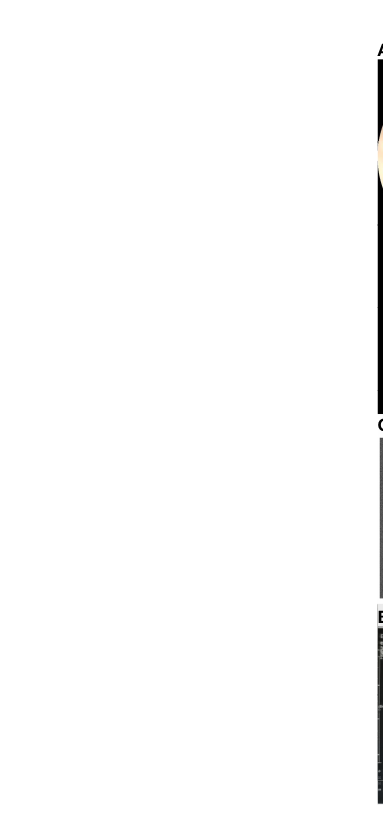
FIGURE 2 | (A) Fundus examination of patient 2 revealed a circumscribed, nodular, white lesion of the retina located in the peripheral quadrant, which was associated with tortious feeding vessels and subretinal yellow-white deposits. (B) The lesion was 4.3 mm thick and its largest basal diameter was 6.8 mm, as measured by CDI. (C) SS-OCT revealed multifocal, punctate, or spot subretinal lesions with medium- to hyper-re fl ectivity involving the lamina cribrosa and the surrounding of the optic nerve, as well as the spot lesions corresponding to subretinal tumor cells in pathological fi ndings. (Green Triangle: super fi cial retinal detachment; Red Pentagram: tumor cell cluster; Yellow triangle: damaged photoreceptor cell layer and suspended tumor cells; Red triangle: discrete subretinal tumor cells; Blue triangle: tumor cells are implanted in the vitreous cavity; (D) Enucleation was performed and pathological fi ndings revealed no in fi ltration in the optic nerve head and the sclera. Green Triangle: inner limiting membrane; Red Pentagram: tumor cell cluster; Yellow triangle: damaged photoreceptor cell layer and suspended tumor cells; Red triangle: discrete subretinal tumor cells; Blue triangle: tumor cells are implanted in the vitreous cavity; White pentagram: suspended tumor cell cluster; tumor cell clusters around the optic nerve, subretinal (yellow pentagram) and epiretinal (green